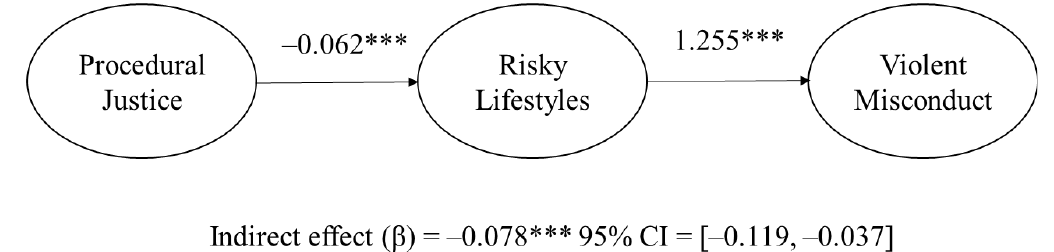
The indirect e ff ect of procedural justice on violent misconduct via risky lifestyles. Figure 2. The indirect effect of procedural justice on violent misconduct via risky lifestyles. Standard Standard coe ffi cients are presented. CI = confidence interval. *** p < coefficients are presented. CI = confidence interval. *** p < 0.001.